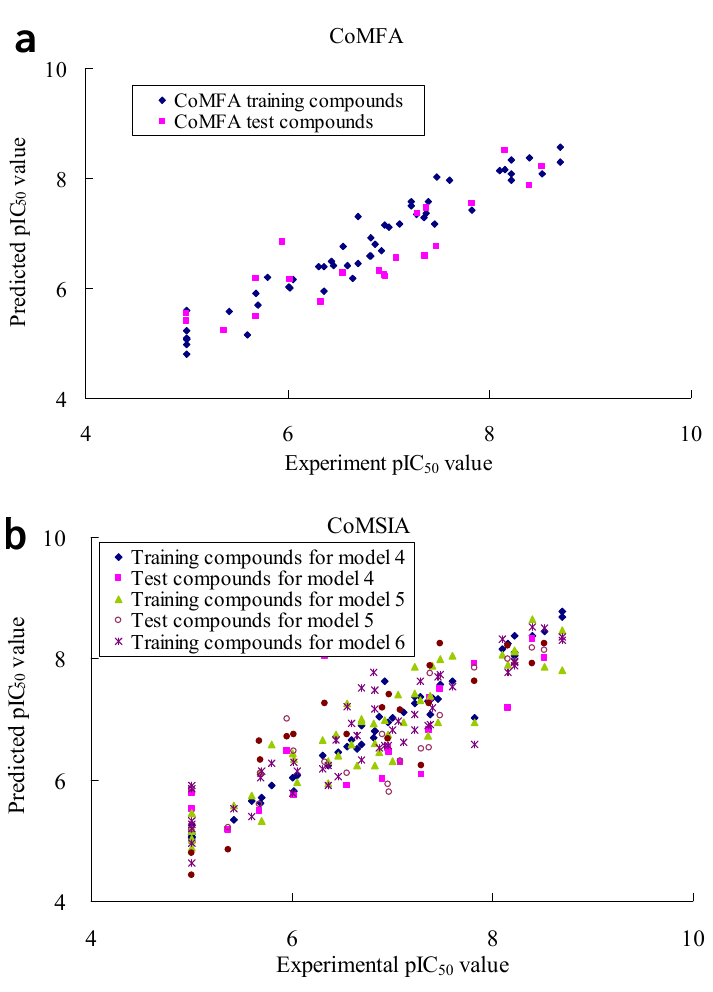
Figure 5. Plot of predicted vs. experimental values of ( a ) CoMFA model 2 and ( b ) CoMSIA models 4, 5 and 6.